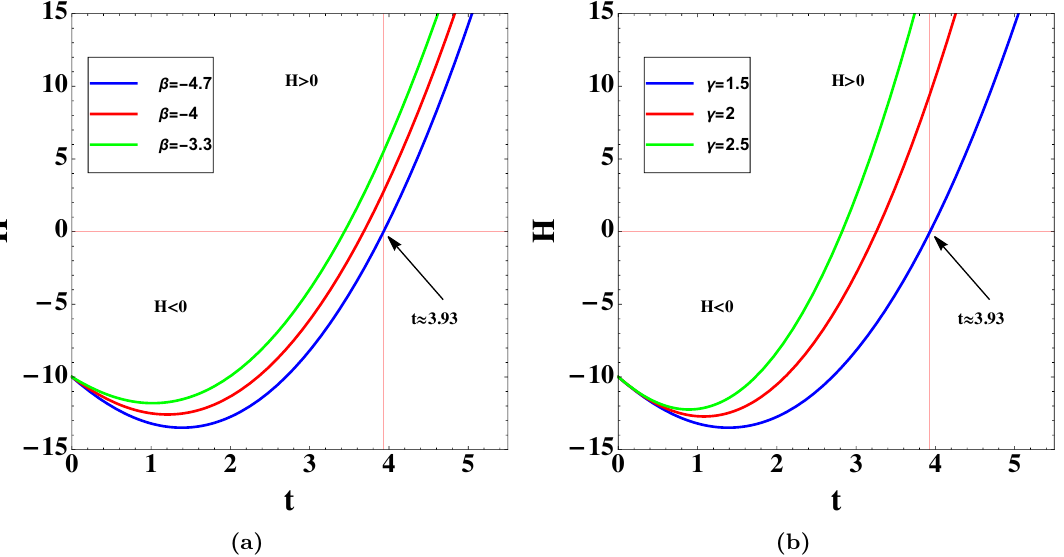
Figure 1. Evolution of the Hubble parameter H as a function of the cosmic time t for distinct values of β and γ respectively.